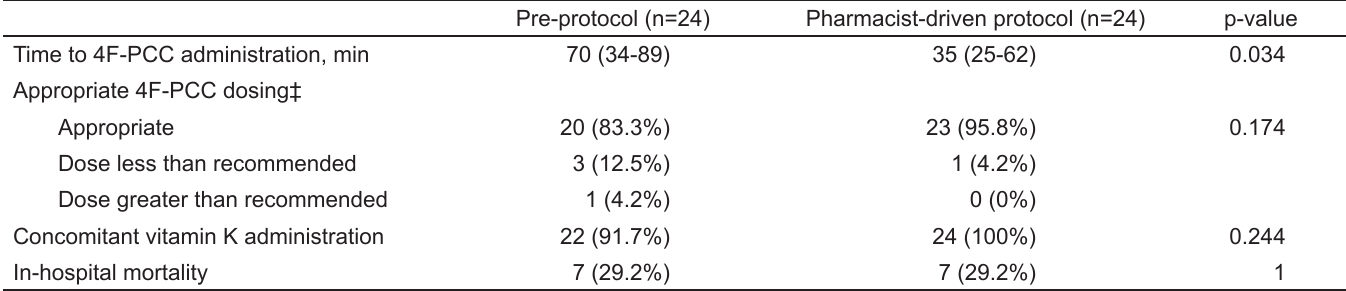
Table 2. Study outcomes